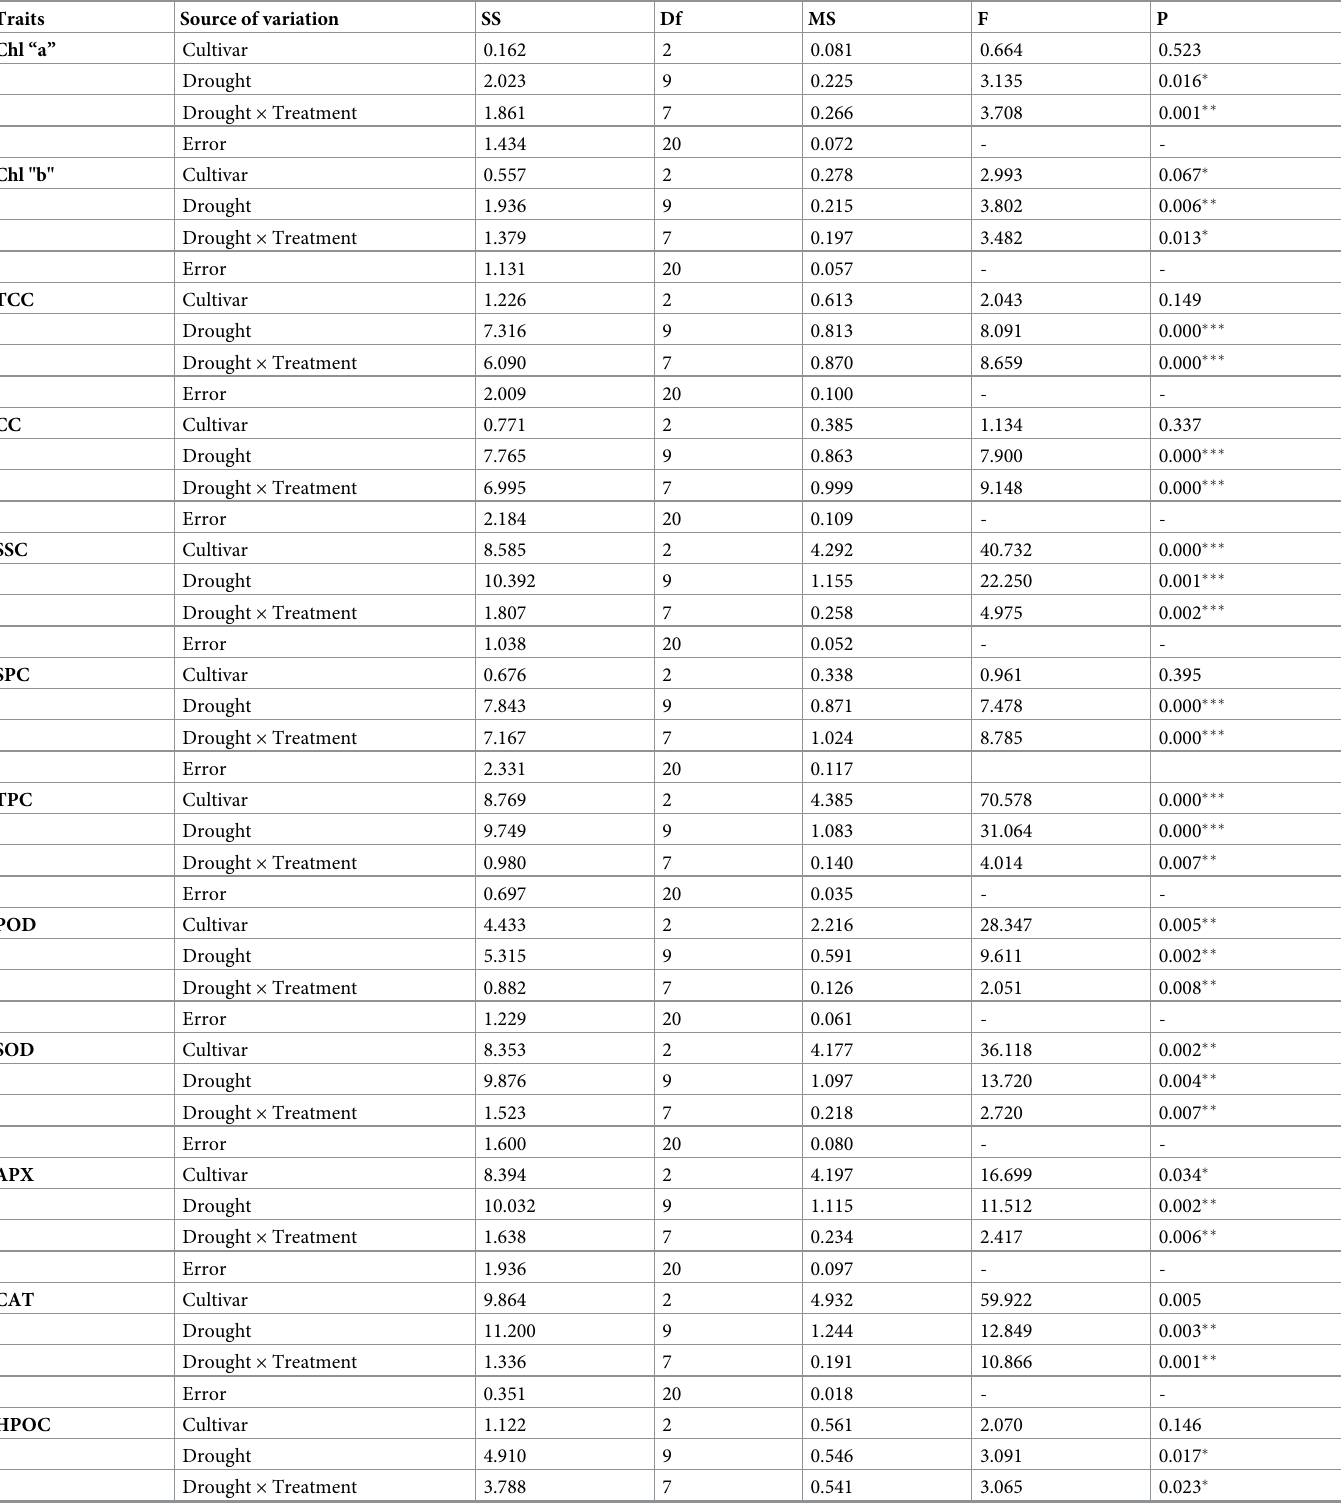
Table 1. Analysis of variance of physio-biochemical attributes of lentil cultivar to varying levels of α -tocopherol under drought induced stress.